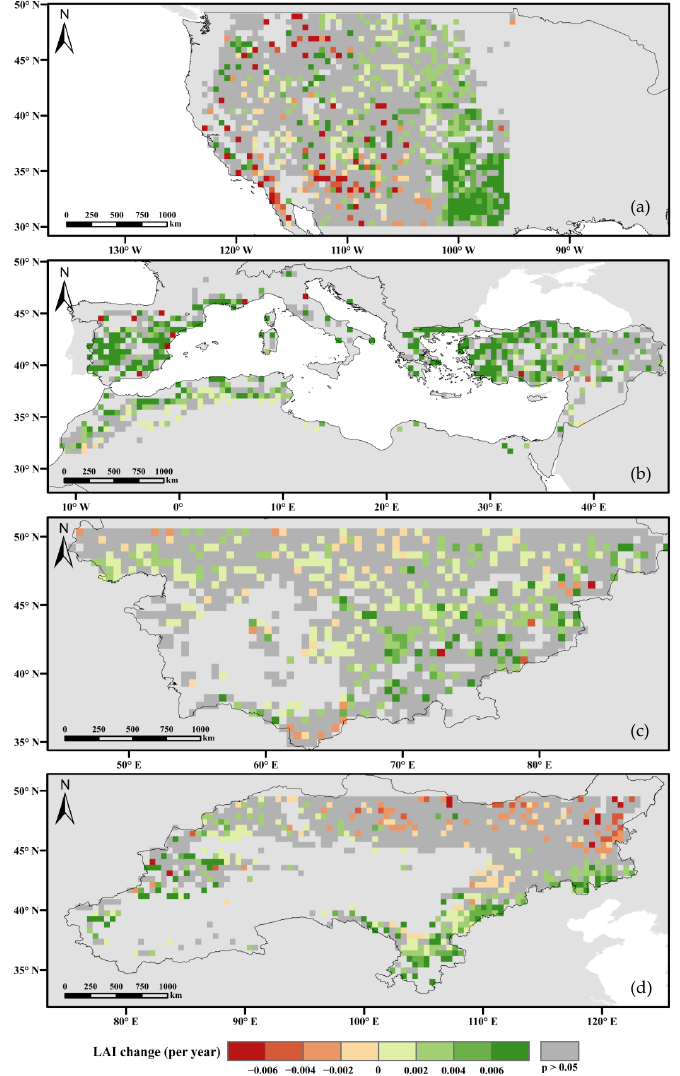
Figure 8. Spatial distribution of the change trends ( p < 0.05) of vegetation LAI over four regions ( a ) North America, ( b ) Mediterranean region, ( c ) Central Asia, and ( d ) East Asia from 1981 to 2018.